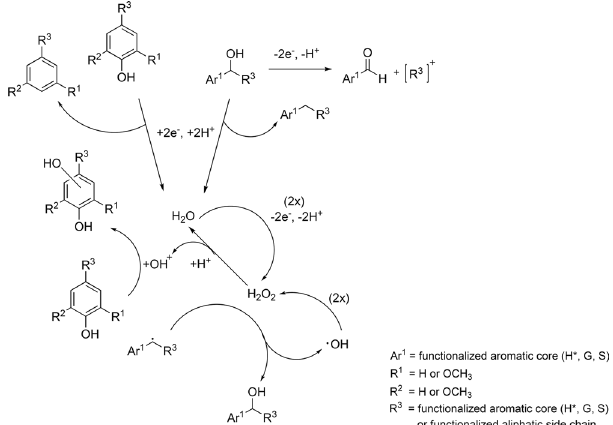
Figure 1. Abbreviated reaction scheme showing proposed electrochemical/radical mechanisms during lignin degradation. The numbers in parentheses give the equivalents of raw material needed for the reaction. Aromatic core units are defined as follows: ( H * ) 4-hydroxybenzyl, ( G ) 3-methoxy-4-hydroxybenzyl, ( S ) 3,5-dimethoxy-4-